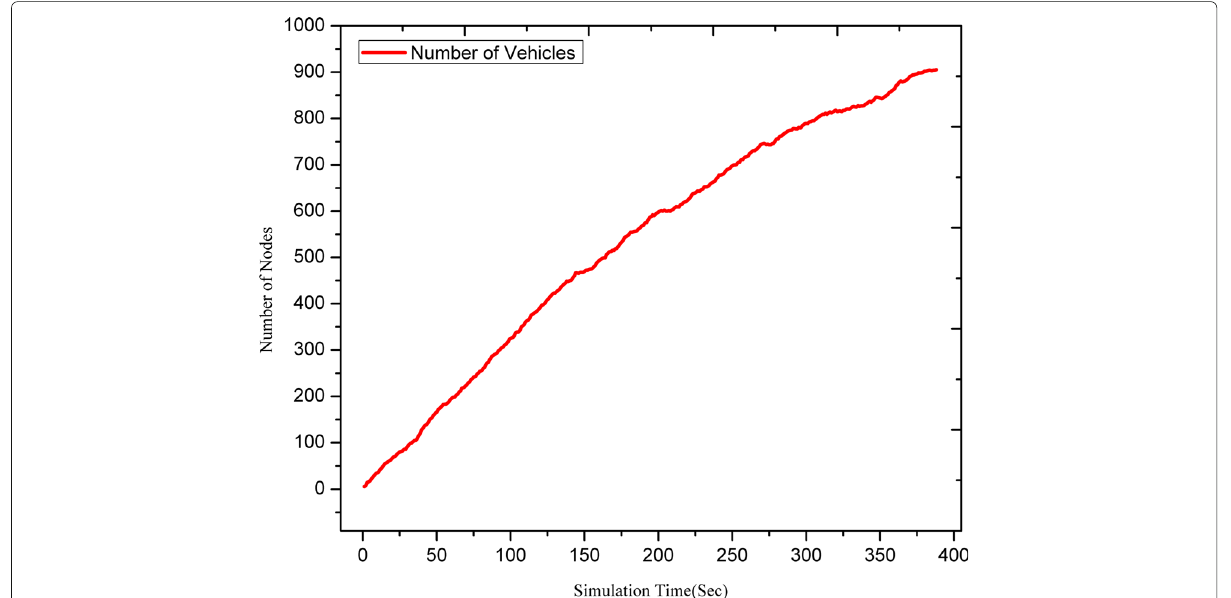
Fig. 6 RLLMR performance on Inter State 5 highway with high traffic variation (different number of